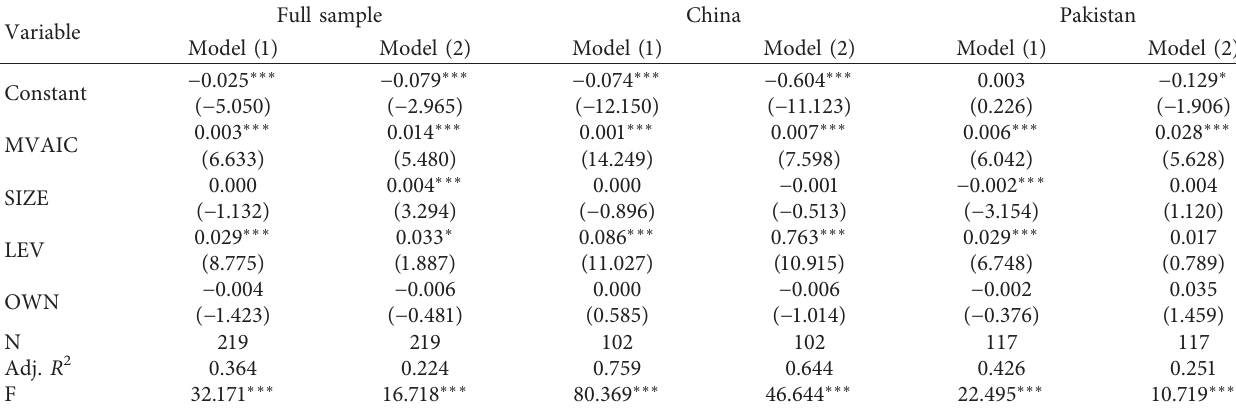
Table 5: Regression results of robustness